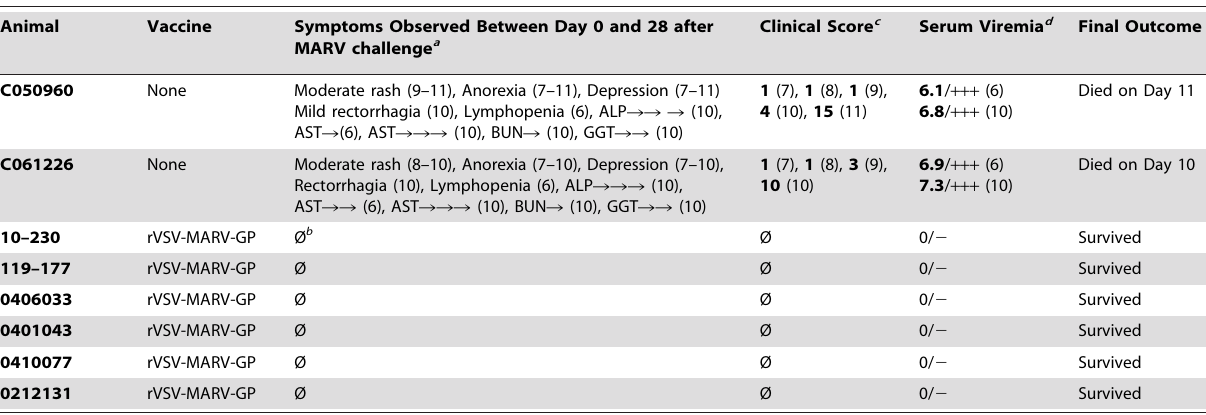
Table 2. Clinical findings and viremia for NHPs challenged with MARV.